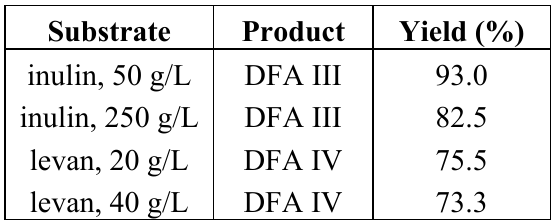
Table 6 . Enzymatic production of DFA III and